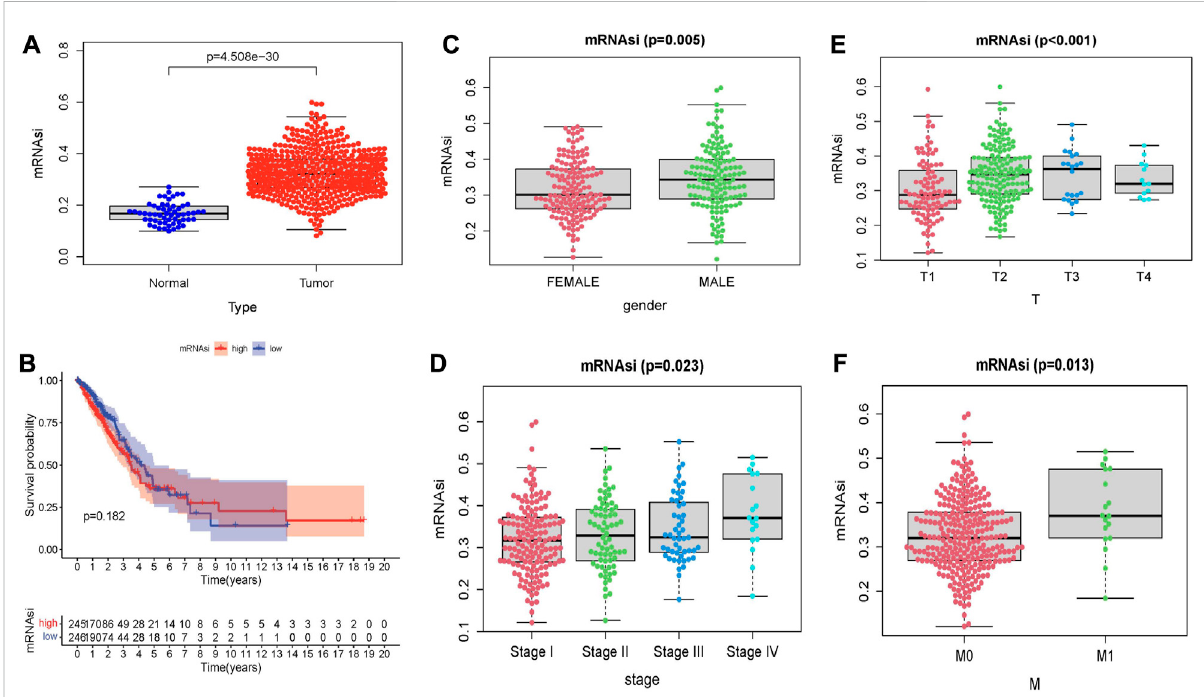
FIGURE 9 Relationship between stem cell index and prognosis and clinicopathological features in LUAD. (A) Differences in mRNAsi between normal and tumor tissues. (B) Kaplan – Meier survival curves of mRNAsi in LUAD. Comparison between mRNAsi expression level and clinical characteristics in LUAD, including (C) gender, (D) tumor grade, (E) T stage, (F) M